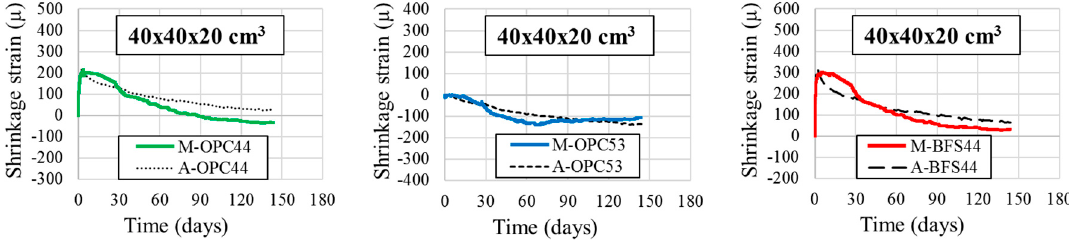
Figure 13. Concrete shrinkage strain in 400 × 400 × 200 mm 3 RC specimens (M-Measured and A-Analytical).